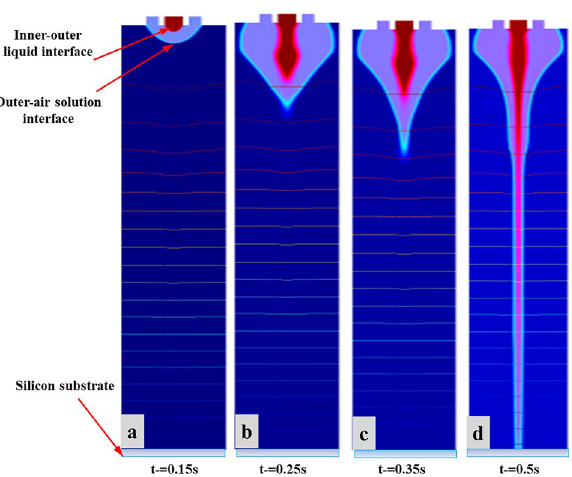
Figure 5. The specific changes of ternary phase field morphologies ( a – d ) at different time steps (0–0.5 s) with applying electric